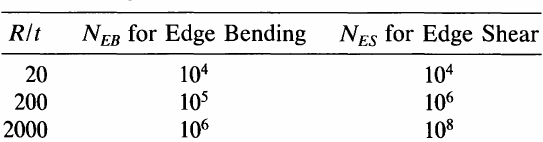
Table 1. Number of Square Elemeuts in Uniform Mesh Needed to Capture Edge Effects in